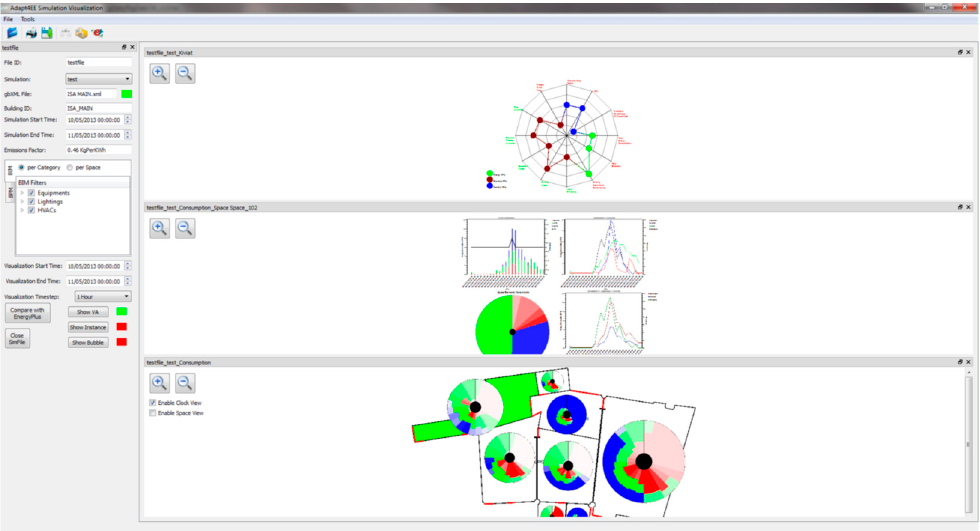
Figure 11. Visual analytics application. The tool gives the possibility to view multiple screens simultaneously. © (2022) IEEE. Reprinted, with permission, from Stavropoulos et al. [53].